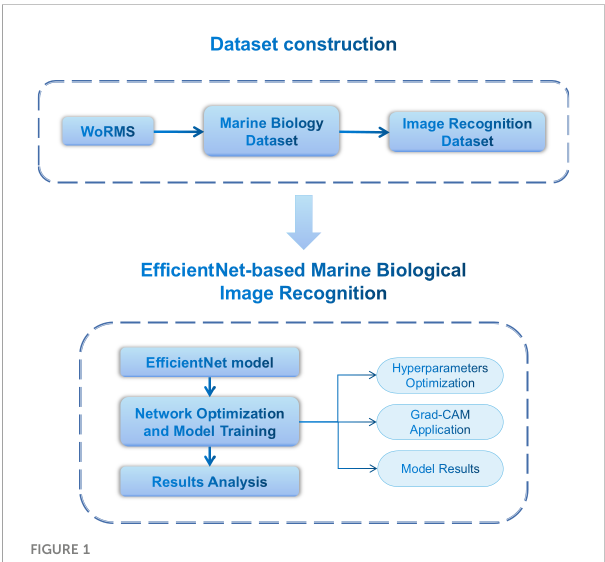
FIGURE 1 The work fl ow of EchoAI in this study. The entire pipeline starts with dataset preparation, followed by model training using deep-learning model, and interpretation of the prediction